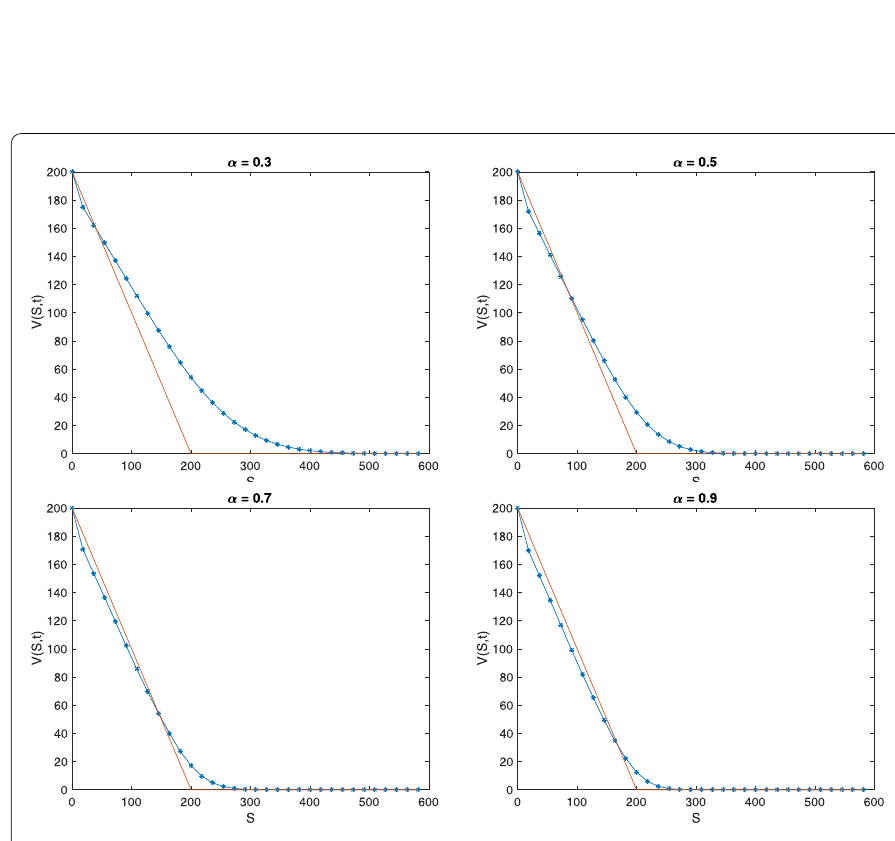
Figure 7 Payoffs under Example 5.2 for α = 0.3,0.5,0.7,0.9; δ = 0.045 at t =